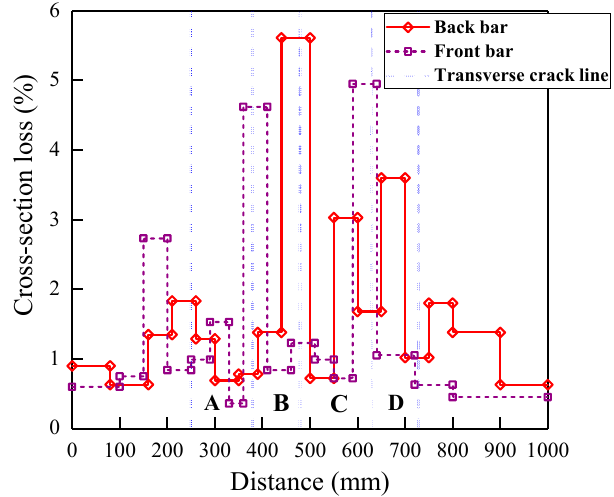
Figure 13. Cross-sectional loss of tensile bars in B-02-3.